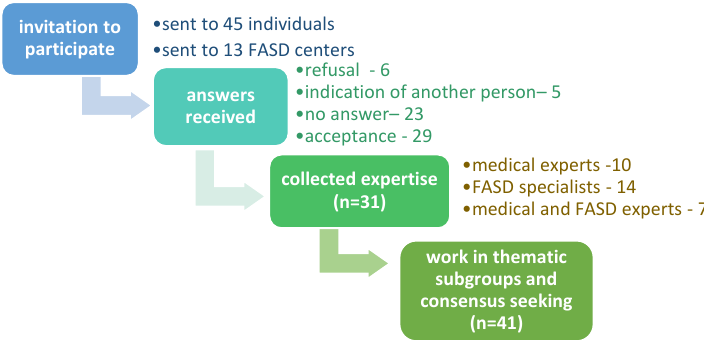
Figure 1. Scheme of creating a team of authors of Polish FASD diagnostic